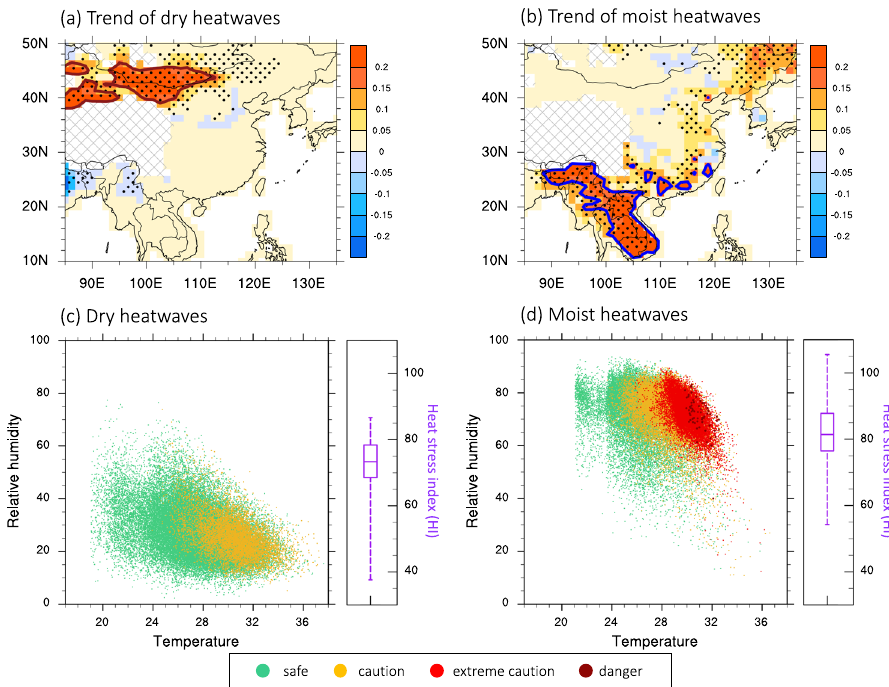
Fig. 1 Linear trends of dry/moist heatwave durations and scatterplot of temperature and relative humidity during heatwave days. a Trend of dry heatwaves and b trend of moist heatwaves [days year − 1 ]. Heatwaves were de fi ned as periods in which the daily mean temperature was above the 90th percentile for at least 3-days (based on JRA-55 data from 1958 to 2019). The dots indicate the 90% con fi dence level using P -values; hatched lines represent geopotential height above 2000 m; red and blue contours represent areas with trend above 0.15 days year − 1 during 1958 – 2019 for a dry and b moist heatwaves, respectively. Scatterplots of 2 m air temperature and 2 m relative humidity (obtained from JRA-55) during heatwave events over regions where the trends of c dry and d moist heatwave durations were above 0.15 days year − 1 , respectively. The green, yellow, red, and dark red colors indicate heat stress categories: safe, caution, extreme caution, and danger, respectively. The purple boxes in c and d are the ranges of the heat stress index (HI) during dry and moist heatwave days, respectively. The different percentiles depicted in each box are, respectively, the 75th, 50th, and 25th percentile values and the upper and lower lines denote the 90th and 10th percentile values,